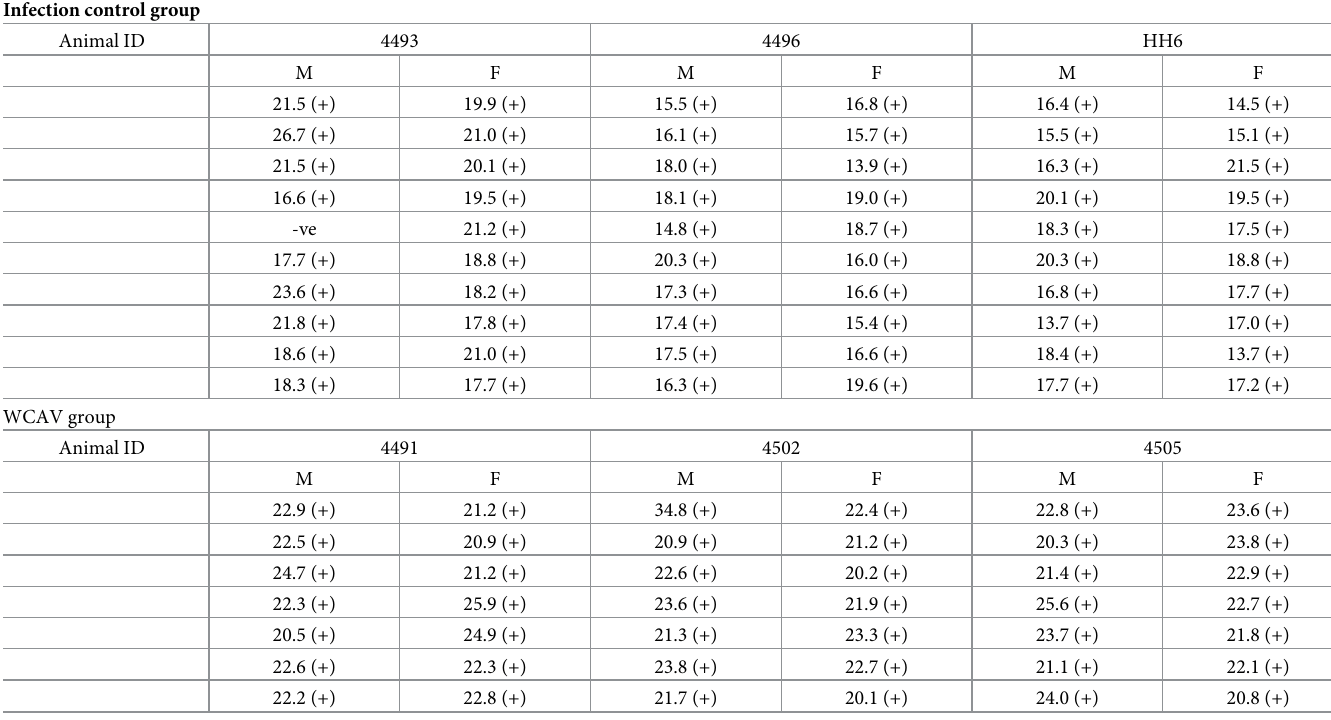
Table 2. TaqMan qPCR data (Ct values) for ticks fed on steers. Infection control group Animal ID